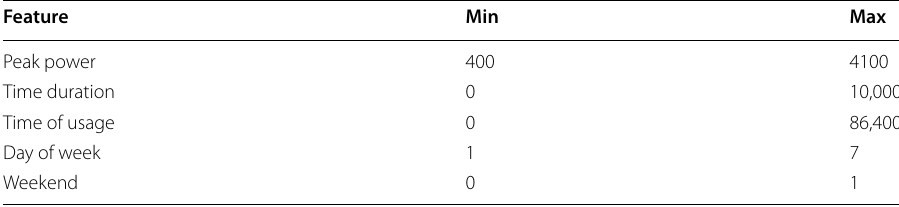
Table 2 Scaling parameters for the input